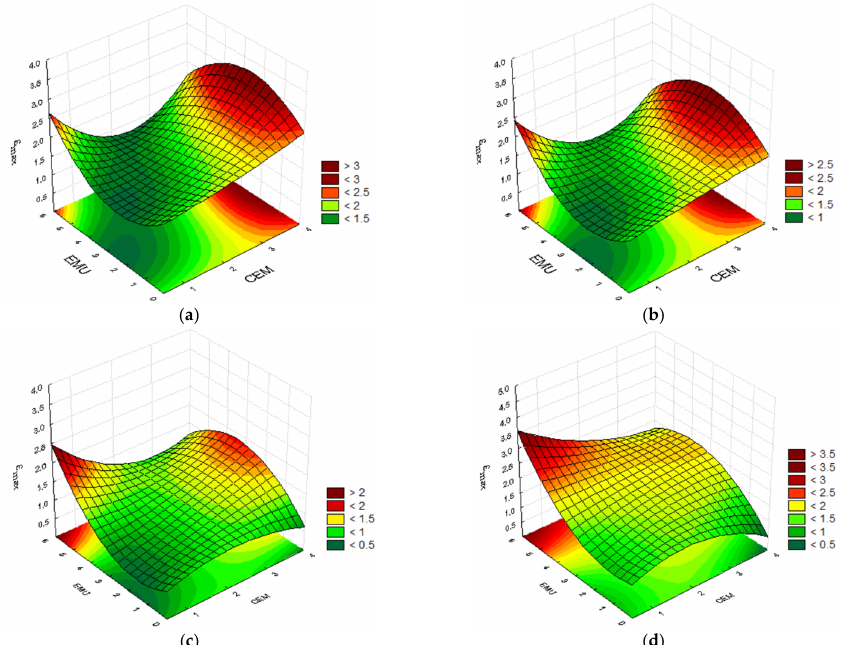
Figure 5. Plots for the strain at maximum force ε max at the temperature of 20 °C, taking into consideration the cement and bitumen emulsion contents and the polymer modifier content of ( a ) 0.0%; ( b ) 0.5%; ( c ) 2.0%; and ( d ) 3.5%.